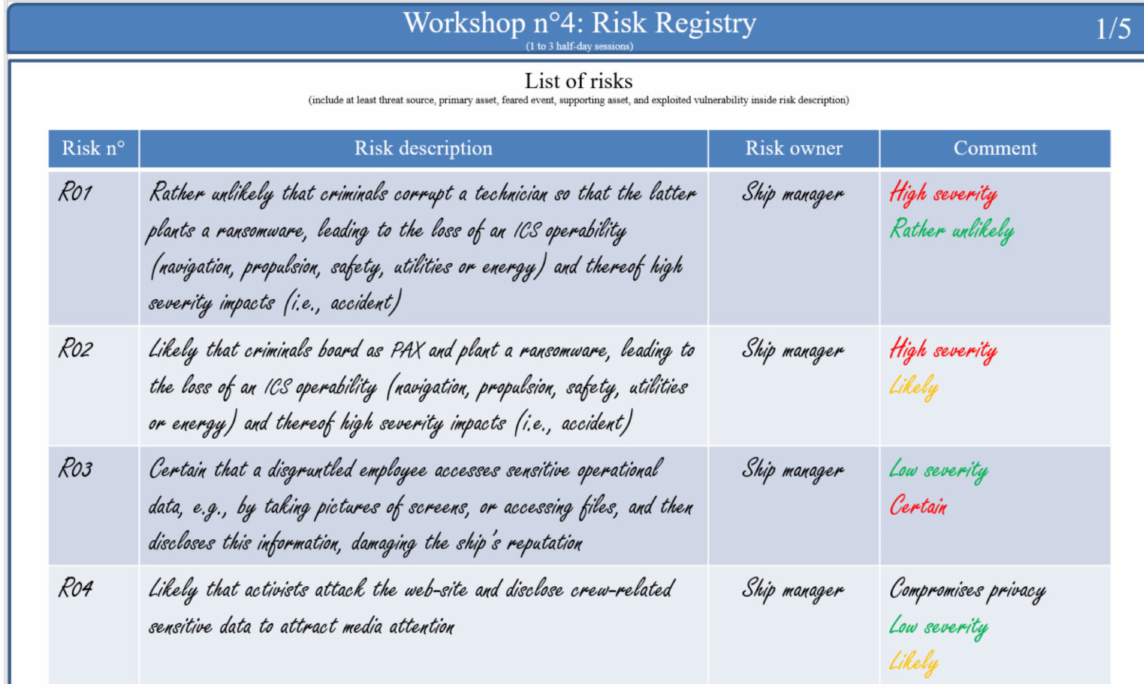
Figure 15. Naval use case—risk